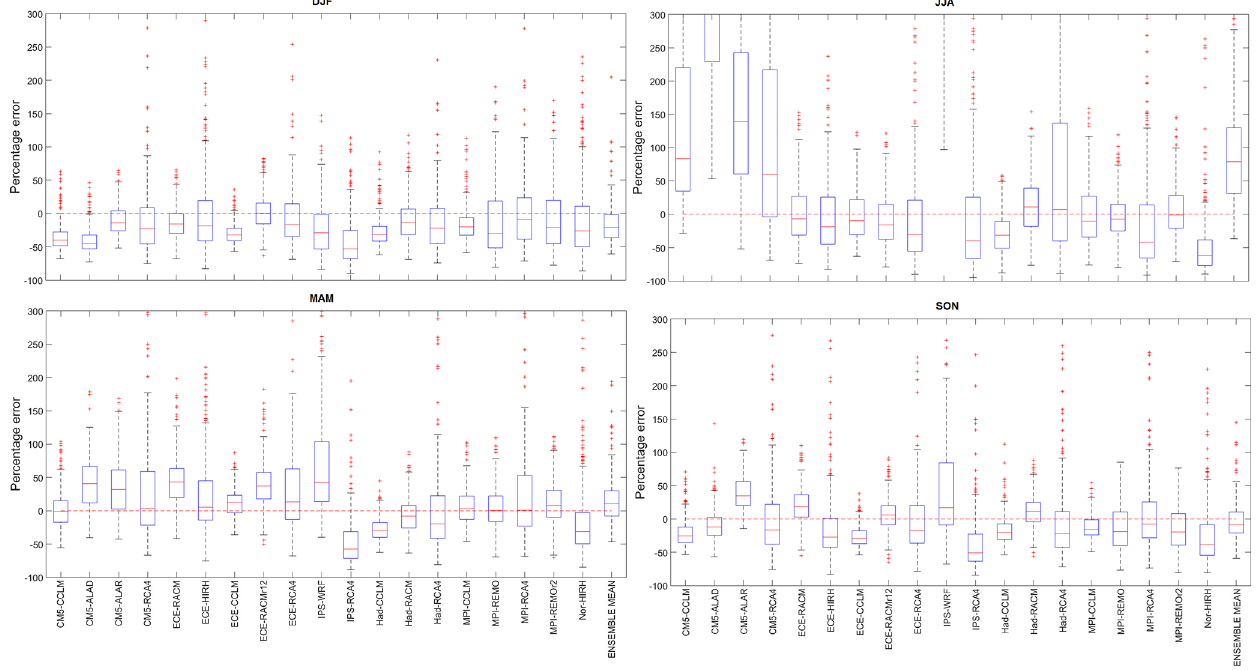
Figure 8. Box plots representing the frequency distribution of RCM percentage errors in seasonal precipitation for the whole study